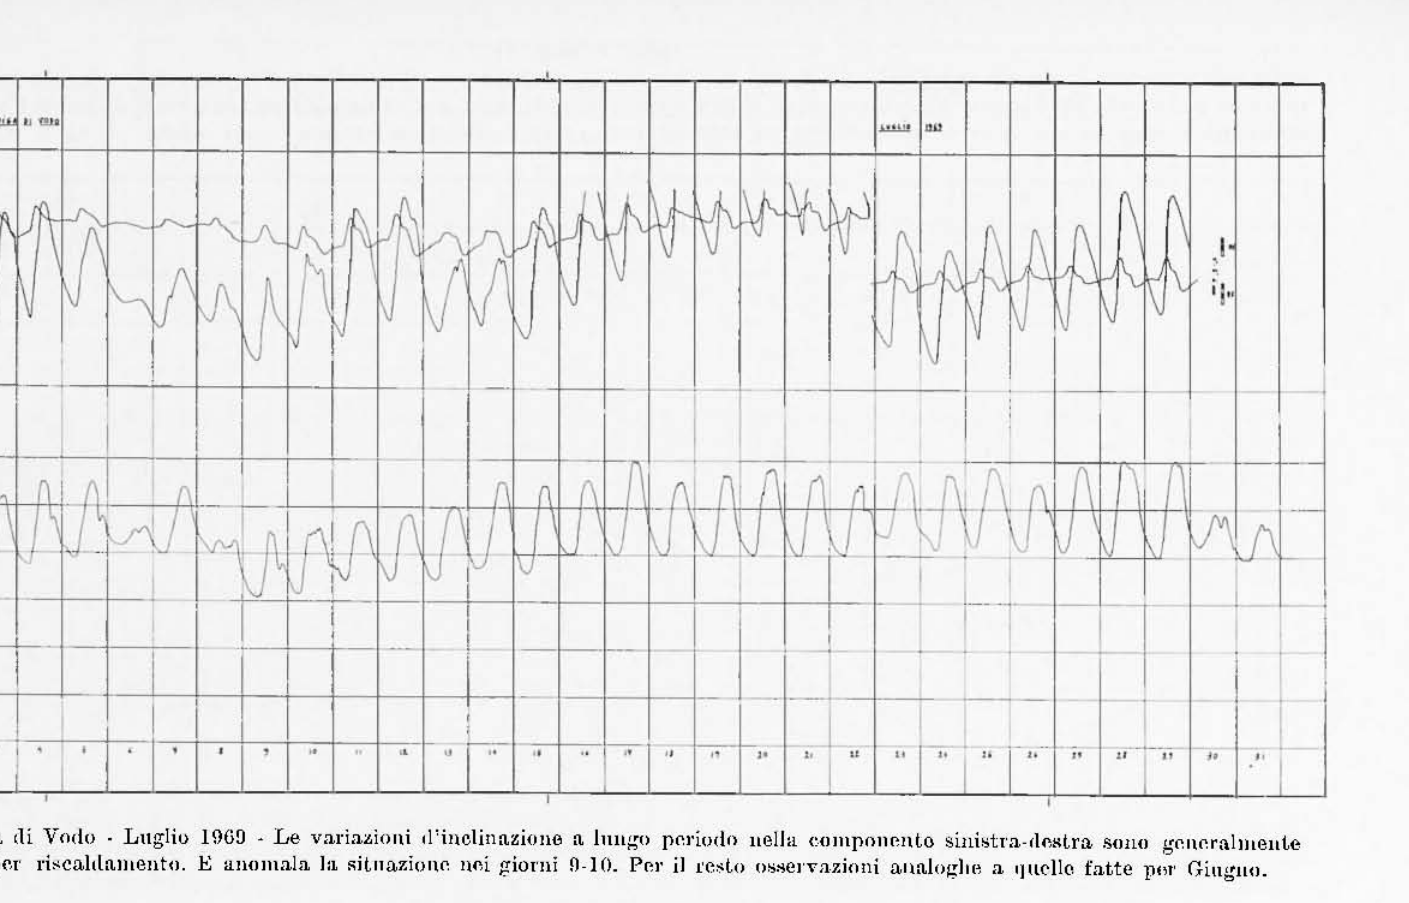
Fig-. !J - Diga ,li Vodo· Luglio HI(j!J . Le variazioni d'inclinazione li. Inug"o p~l'iod(} uella eOlllpnllPllto silli~tl'a-(lm\tra SOllO I;PIIPrallllcuie li. destra !leI' ri~ca!tLalllellt(). E anomala la ~itllaziol\P l\l1i giorni O-IO. Per il l'C~t() o~"e]'vazi{)ni ana)og"lill a 'plC'lle fatte pElI'